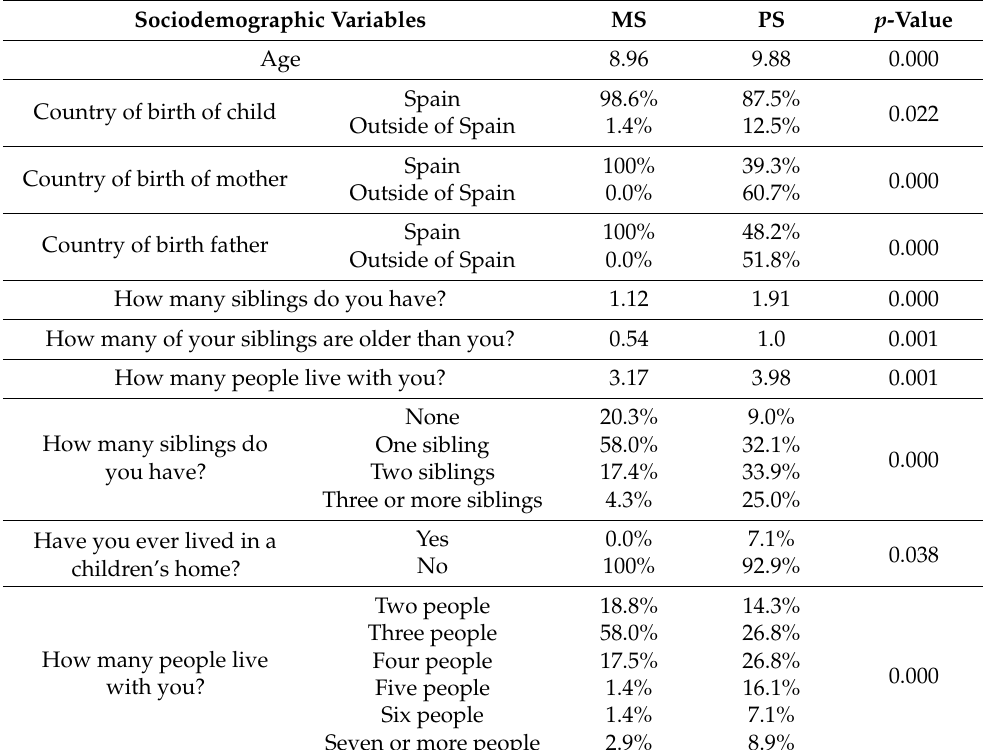
Table 1. Association between sociodemographic variables and type of schooling.